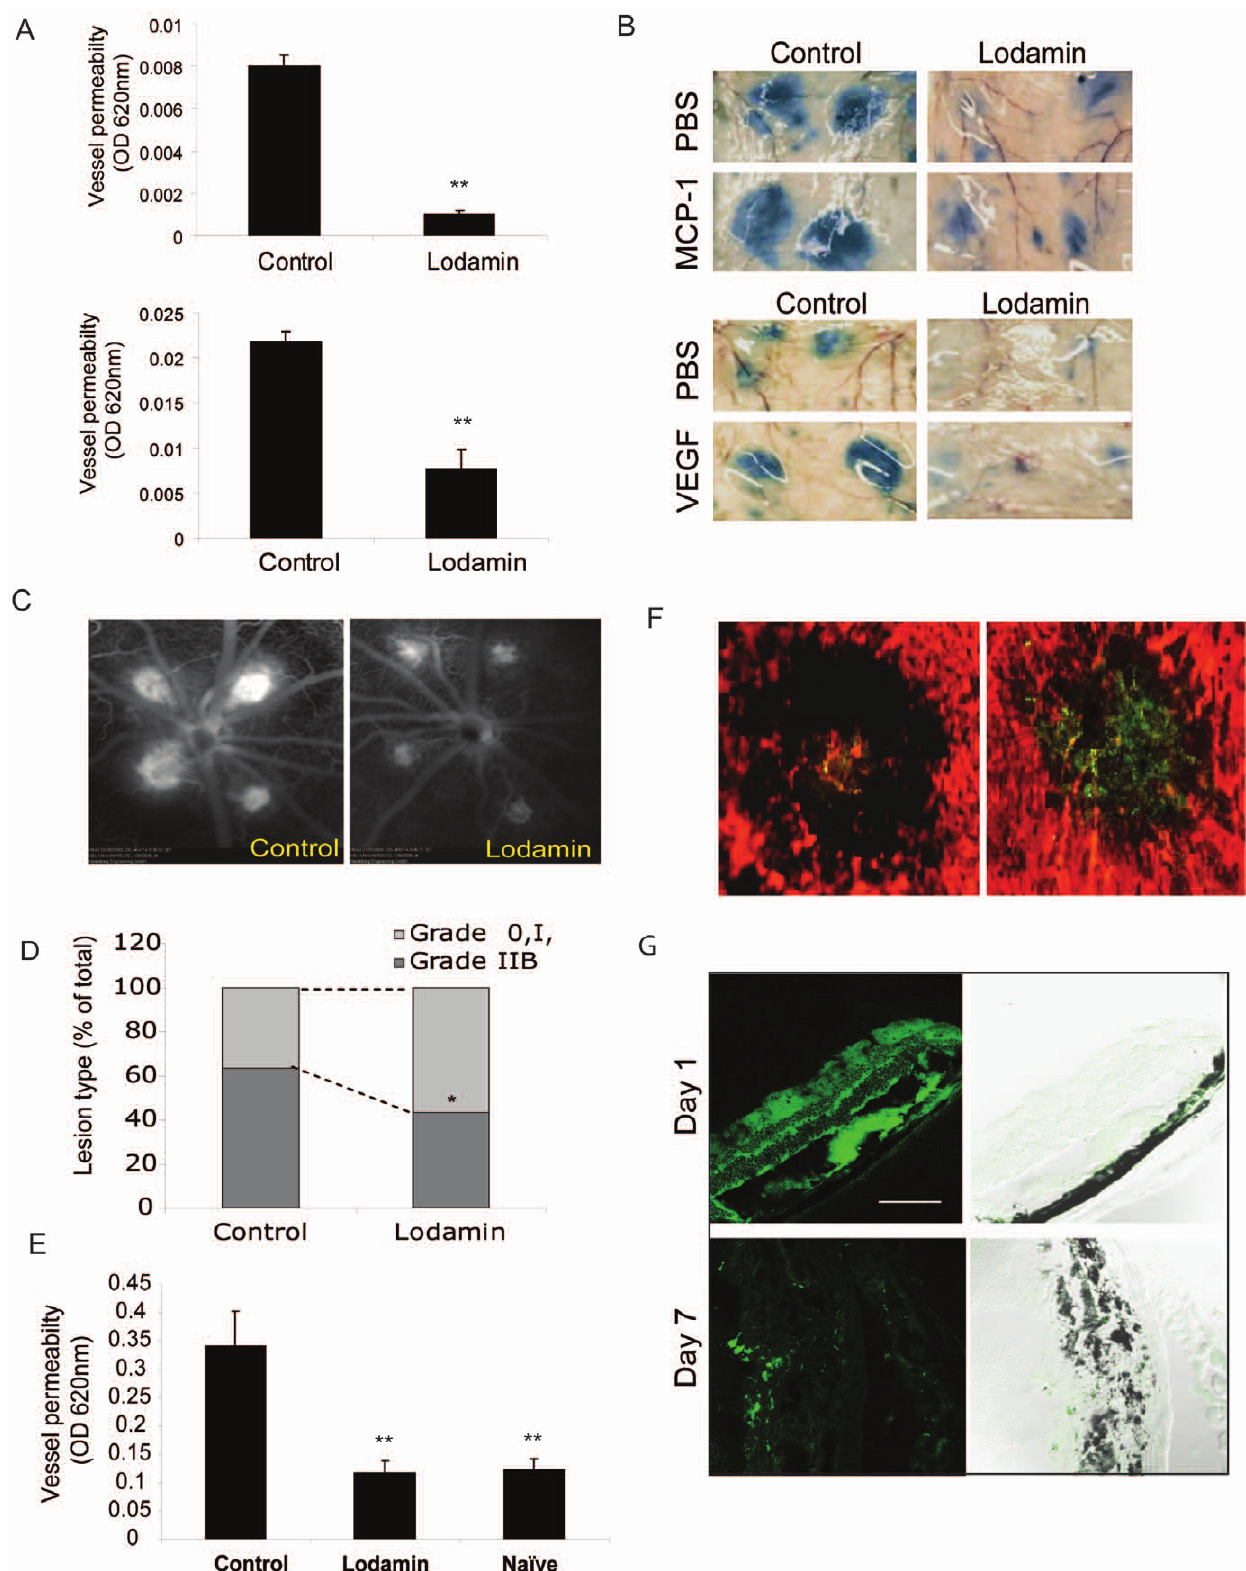
Figure 7. Lodamin reduces vessel permeability in the modified Miles assay and in retinal angiography. ( A ) Left: quantification of modified Miles assays performed in mice after induction of vessel permeability using MCP-1 (50 pg) and VEGF (50 ng); extracted dye contents were quantified by measuring at 620 nm. Data are expressed as mean 6 SEM (n=10, *P , 0.05, t-test). ( B ) Representative photos of mouse skin showing